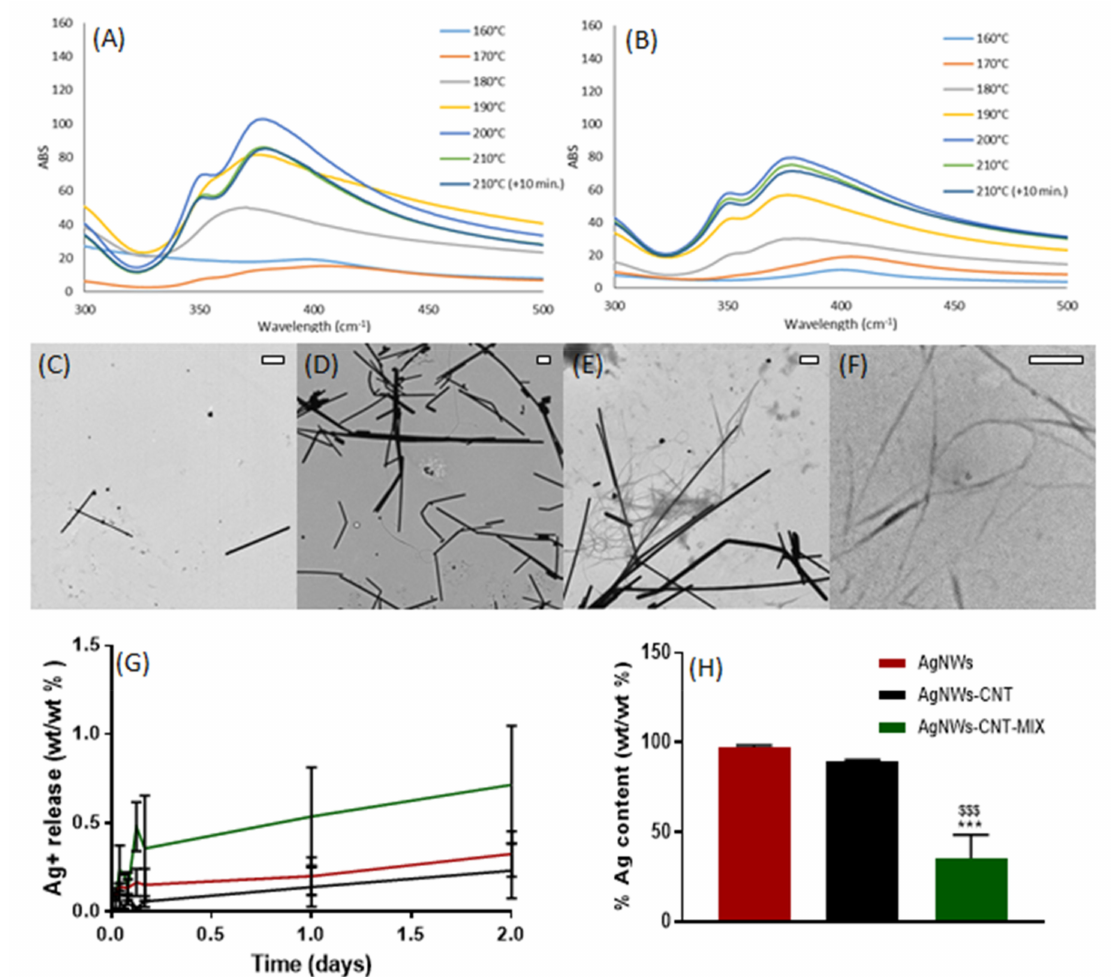
Figure 1. Physicochemical characterization of synthesized products. UV-spectra of ( A ) AgNWs and ( B ) of AgNWs-CNT at di ff erent temperatures during the synthesis reaction. TEM images of ( C ) AgNWs (scale bar 500 nm), ( D ) AgNWs-CNT (scale bar 500 nm), ( E ) AgNWs-CNT-mix (scale bar 500 nm) and ( F ) CNTs (scale bar 500 nm). ( G ) Silver release from AgNWs, AgNWs-CNT and AgNWs-CNT-mix measured by ICP-OES and expressed as wt / wt%. ( H ) Silver contents measured by ICP-OES in AgNWs, AgNWs-CNT and AgNWs-CNT-mix ( n = 3). One-way ANOVA returned p < 0.05; Post-hoc